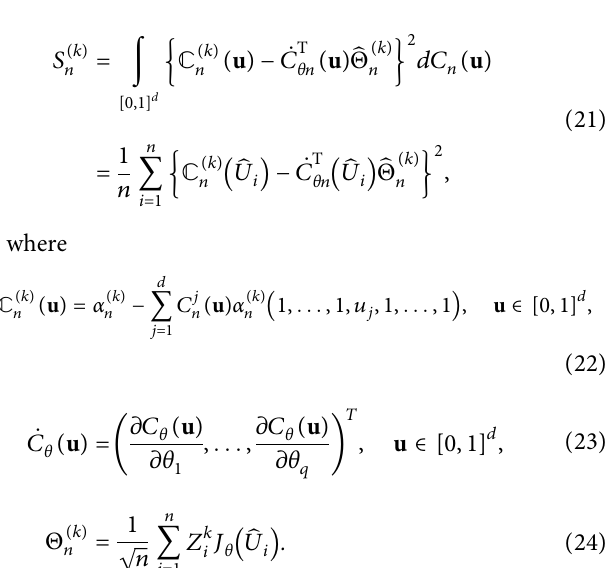
Figure 2: Schematic diagram of the bridge (unit: